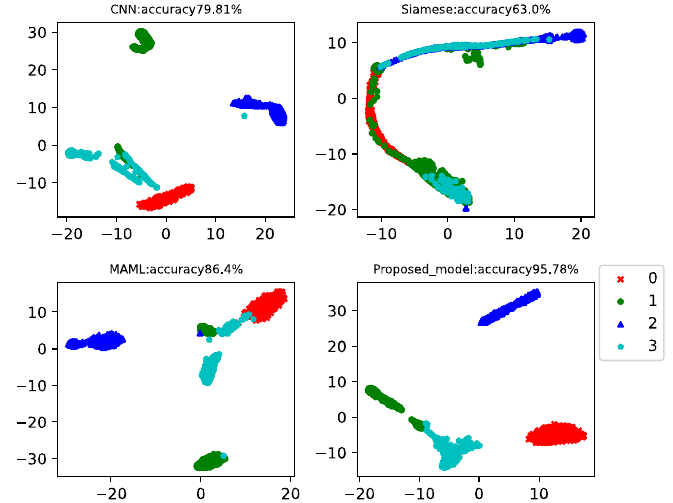
Figure 5. Four-way-one-shot diagnosis of the CWRU data for different algorithms.